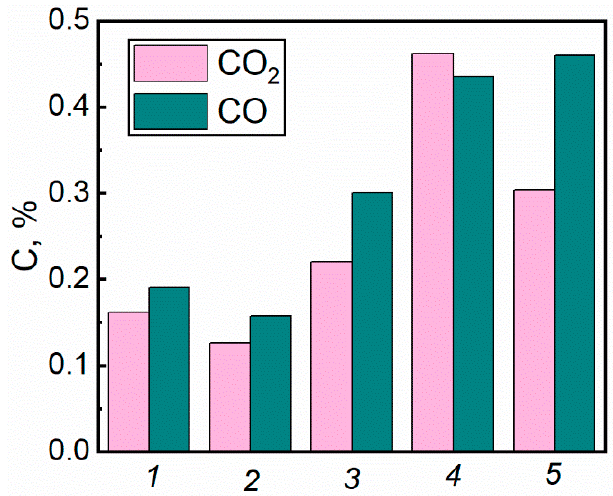
Figure 7. Average concentrations of fl ue gas components produced by the extinguishment of di ff er- ferent types of forest fuels with water, as follows: 1 —twigs; 2 —timber; 3 —leaves; 4 —needles; and ent types of forest fuels with water, as follows: 1— twigs; 2 —timber; 3— leaves; 4— needles; and 5— 5 —mixture of forest mixture of forest fuels.